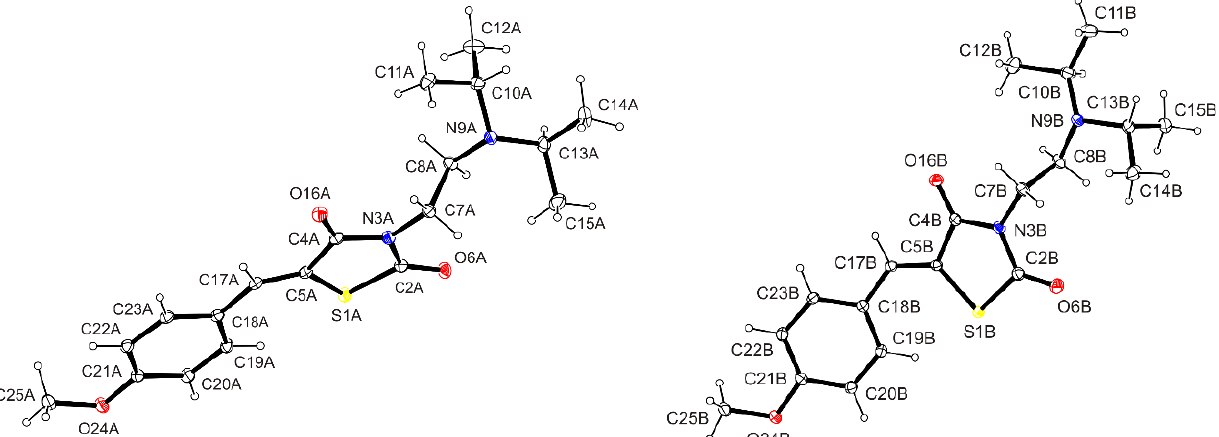
Figure 2. ORTEP view of the two symmetry-independent molecules of 3 , showing the atomic labelling scheme. Non-H atoms are drawn as displacement ellipsoids at the 30% probability level. H atoms are drawn as spheres of arbitrary radii.